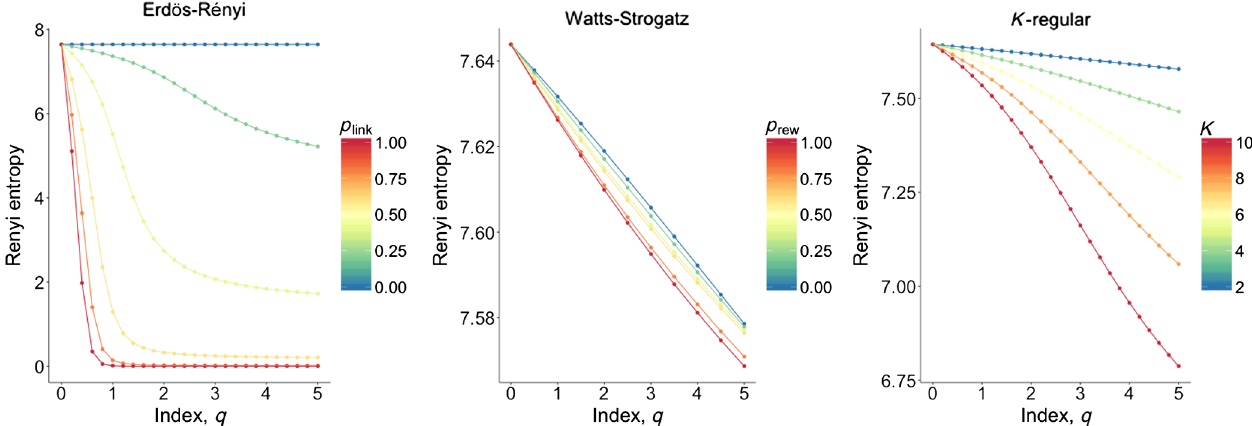
FIG. 4. Rényi entropy of complex network models. Entropy as a function of q with β ¼ 1 = 15 . 8 for Erdös-Rényi networks (left), Watts- Strogatz ’ s small-world networks (center), and K -regular lattices (right). Color encodes realizations obtained by varying the parameter of the network model, i.e., the probability p of a link between two nodes, the rewiring probability p , and the number of neighbors K , link rew respectively. In all cases, networks with N ¼ 200 are